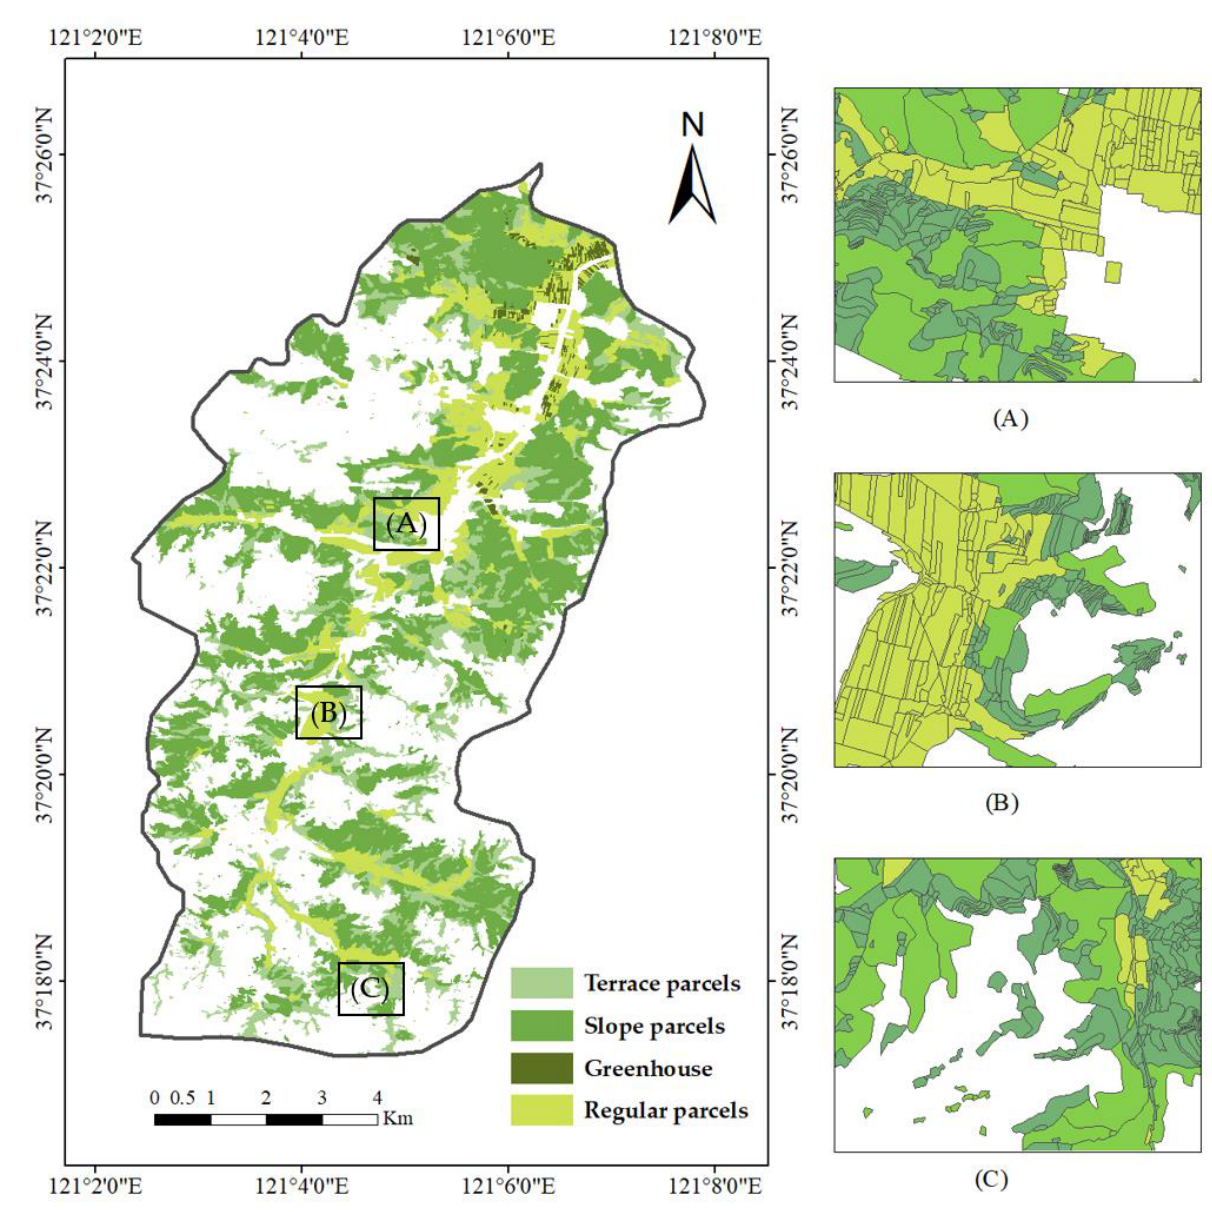
Figure 8. The distribution map of farmland parcels in the study area using the proposed method. ( A – C ) are subregions of the study area.